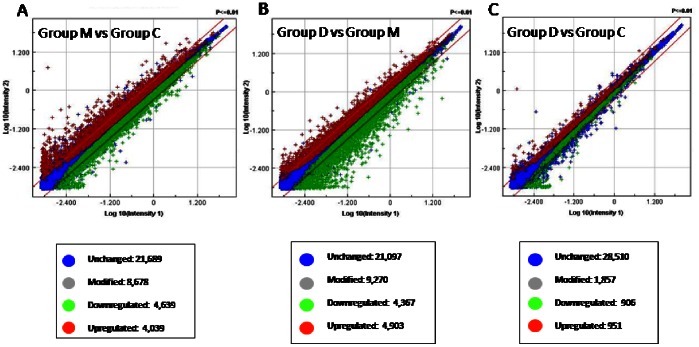
VSL#3 reverses the NMS-induced alteration of gene expression: global microarray analysis.(A) Expression of 8,678 (28.57% of total) genes was globally modified in NMS animals compared with normal rats (Group M vs Group C): 4,039 (13.29%) were upregulated and 4,639 (15.27%) were downregulated. (B) VSL#3 effectively resected gene expression in NMS rats (Group D vs Group M): 9,270 (30.5% of total) genes were globally modified, 4,903 (16.14 of total%) were upregulated, while 4,367 (14.38% of total) were downregulated. (C) VSL#3 administration to NMS rats caused a pattern of gene expression that was similar to that of control rats (Group D vs Group C). Microarray data from 3–4 replicates.